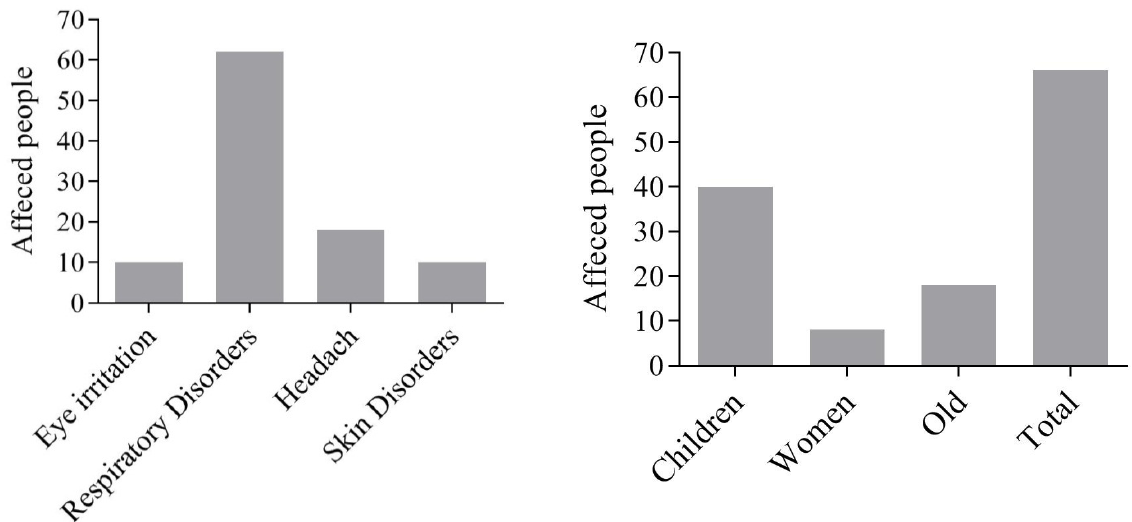
Figure 4. Affected people and disease prevalence from smoke near the brick kiln in the study